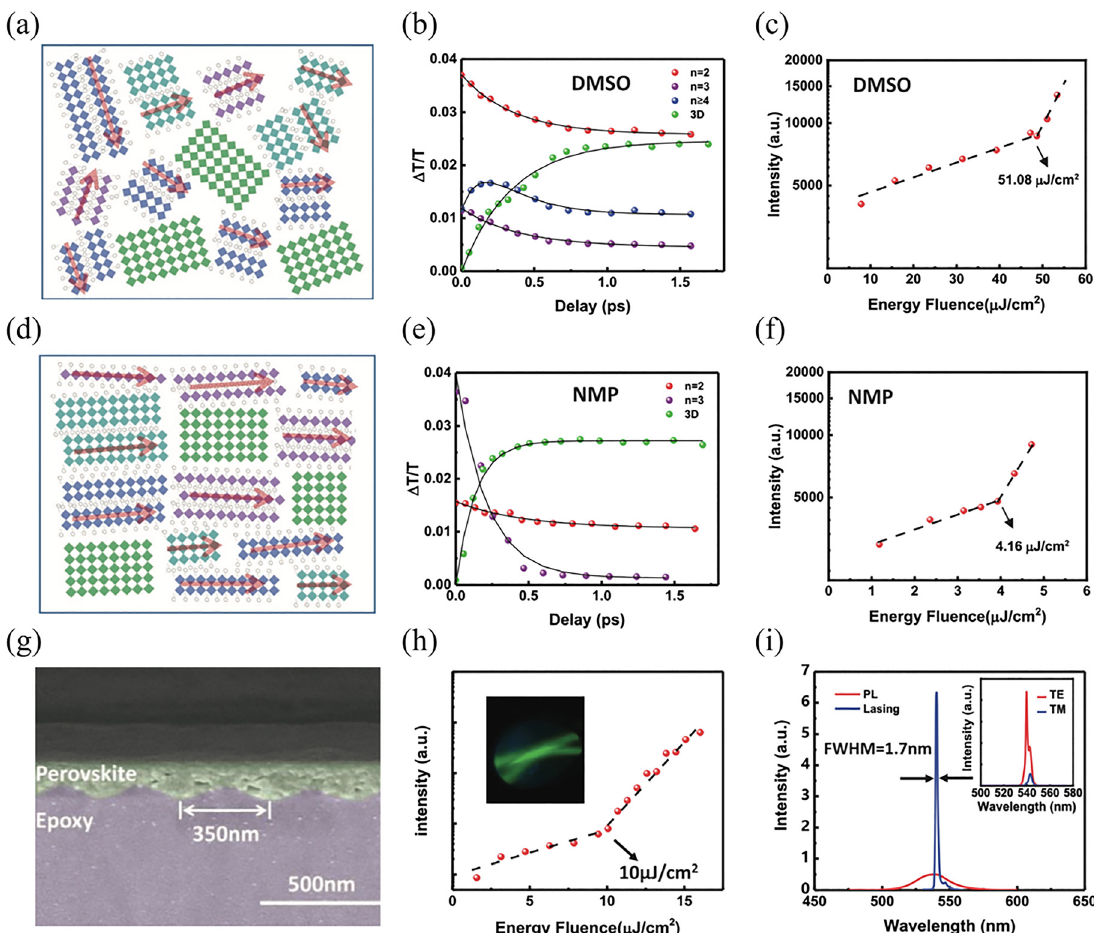
Figure 5: (a), (b), and (c) Diagram, photobleaching dynamic and pumping fluence-dependent emission intensity of quasi-2D perovskite with random orientation using DMSO as solvent. (d), (e), and (f) Diagram, photobleaching dynamic and pumping fluence-dependent intensity of quasi-2DperovskitewithpreferentialorientationusingNMFassolvent.(g),(h)and(i)SEMmorphology,lasingthresholdandPLspectraofDFB lasers based on well-orientation quasi-2D perovskite thin fi lms. Reproduced with permission [38]. © 2020 WILEY ‐ VCH Verlag GmbH & Co. KGaA, Weinheim.